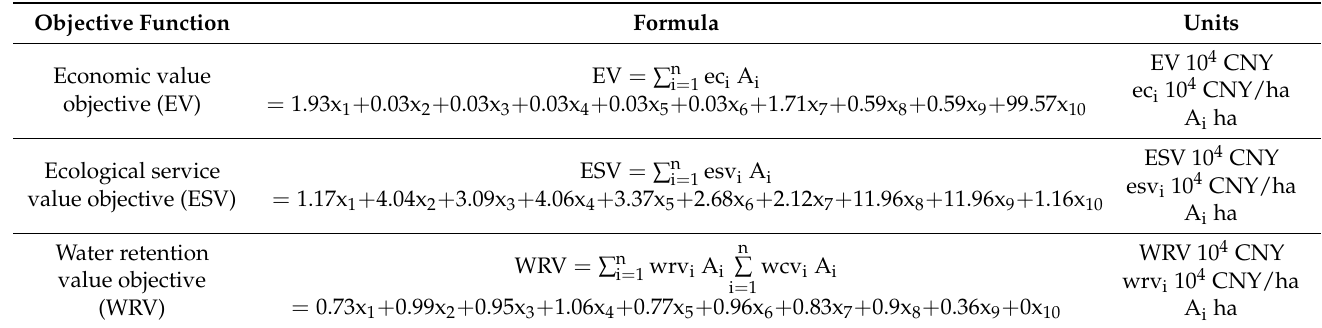
Table 2. Objective function of land use demand optimization model. CNY: China Yuan.